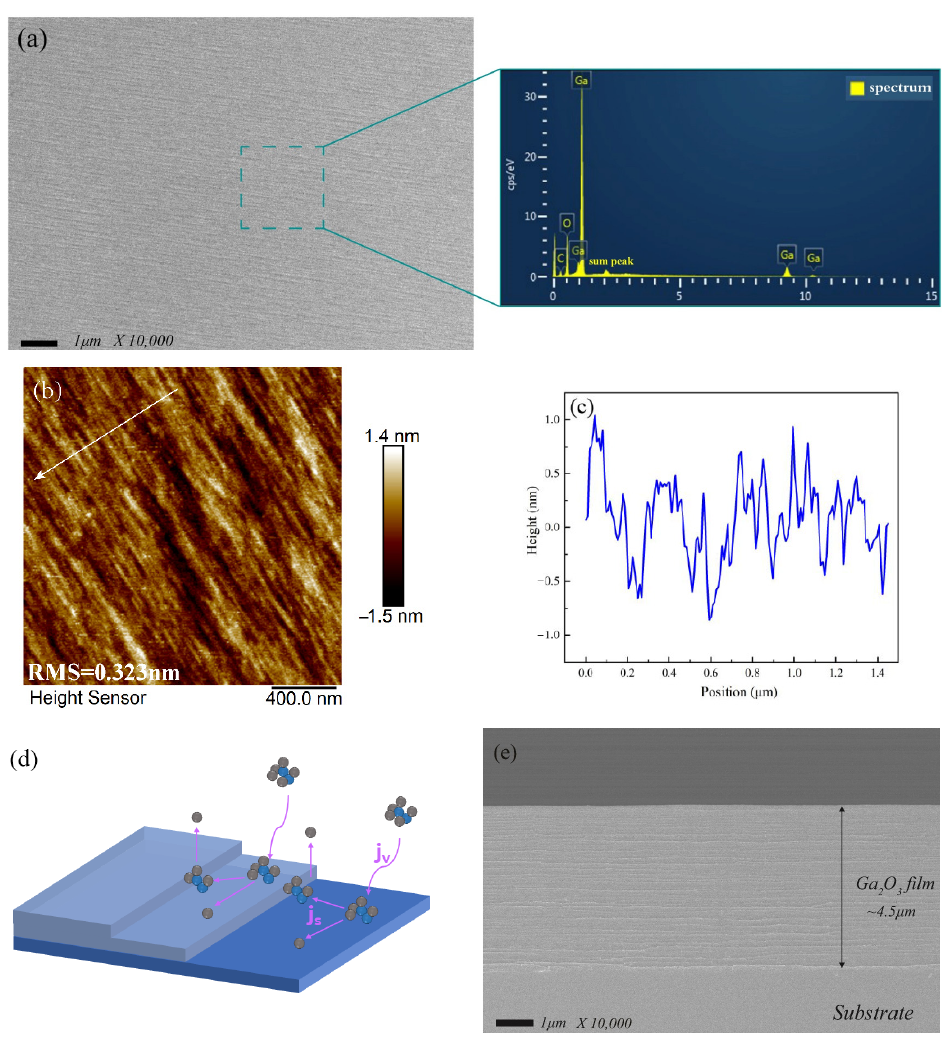
Figure 3. Image of the single crystalline film; ( a ) top-view SEM; ( b ) AFM; ( c ) height profile along the white arrow in Figure 2b; ( d ) stages in the process of step flow growth mode; ( e ) cross-sectional view SEM.